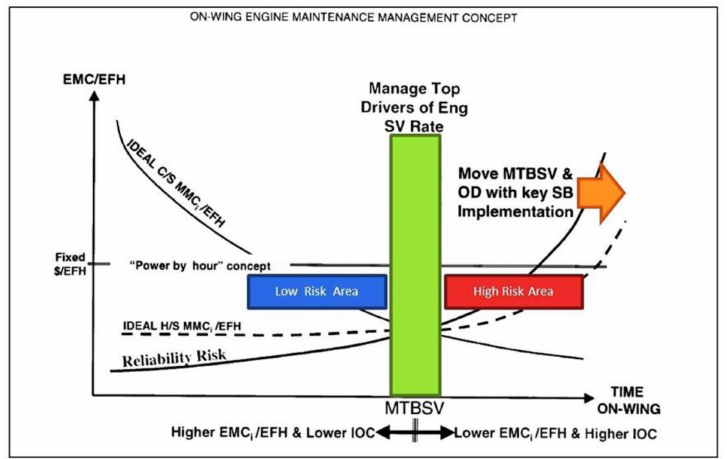
Figure 12. Engine maintenance material cost per engine flight hour (EMC / EFH) vs time on wing qualitative